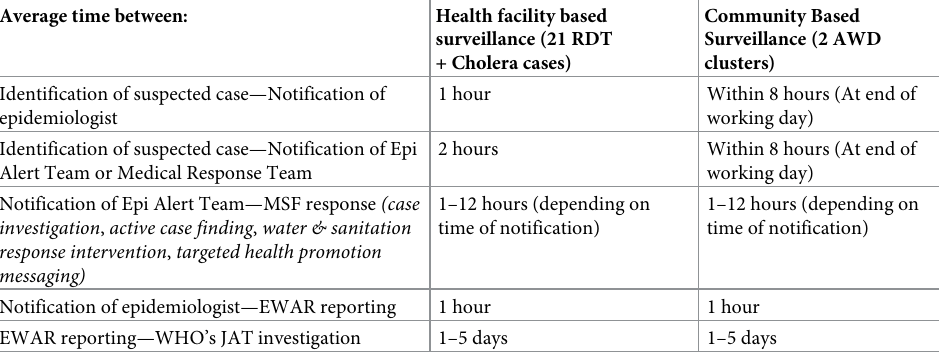
Table 6. Timeliness of MSF’s health facility based surveillance versus CBS in Cox’s Bazar, Bangladesh, week 20– 44, 2019 � . Average time